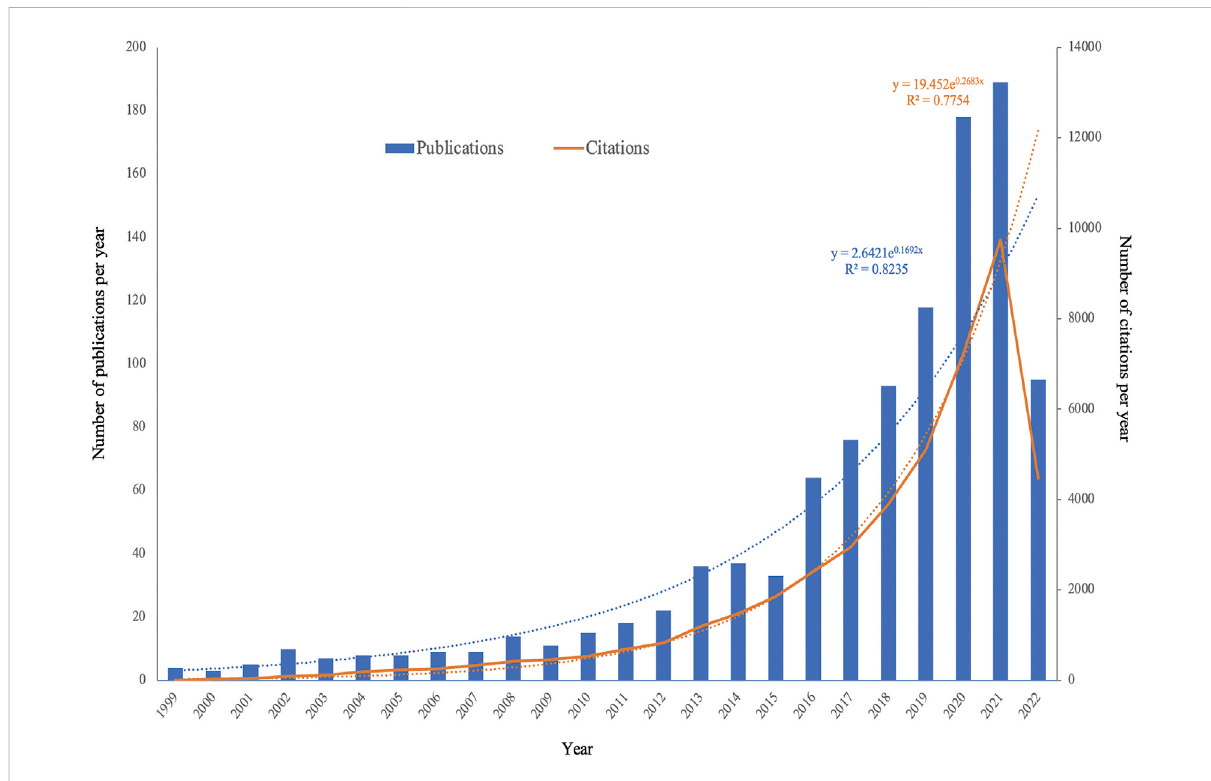
FIGURE 2 Annual publication and annual citation trends in the past 22